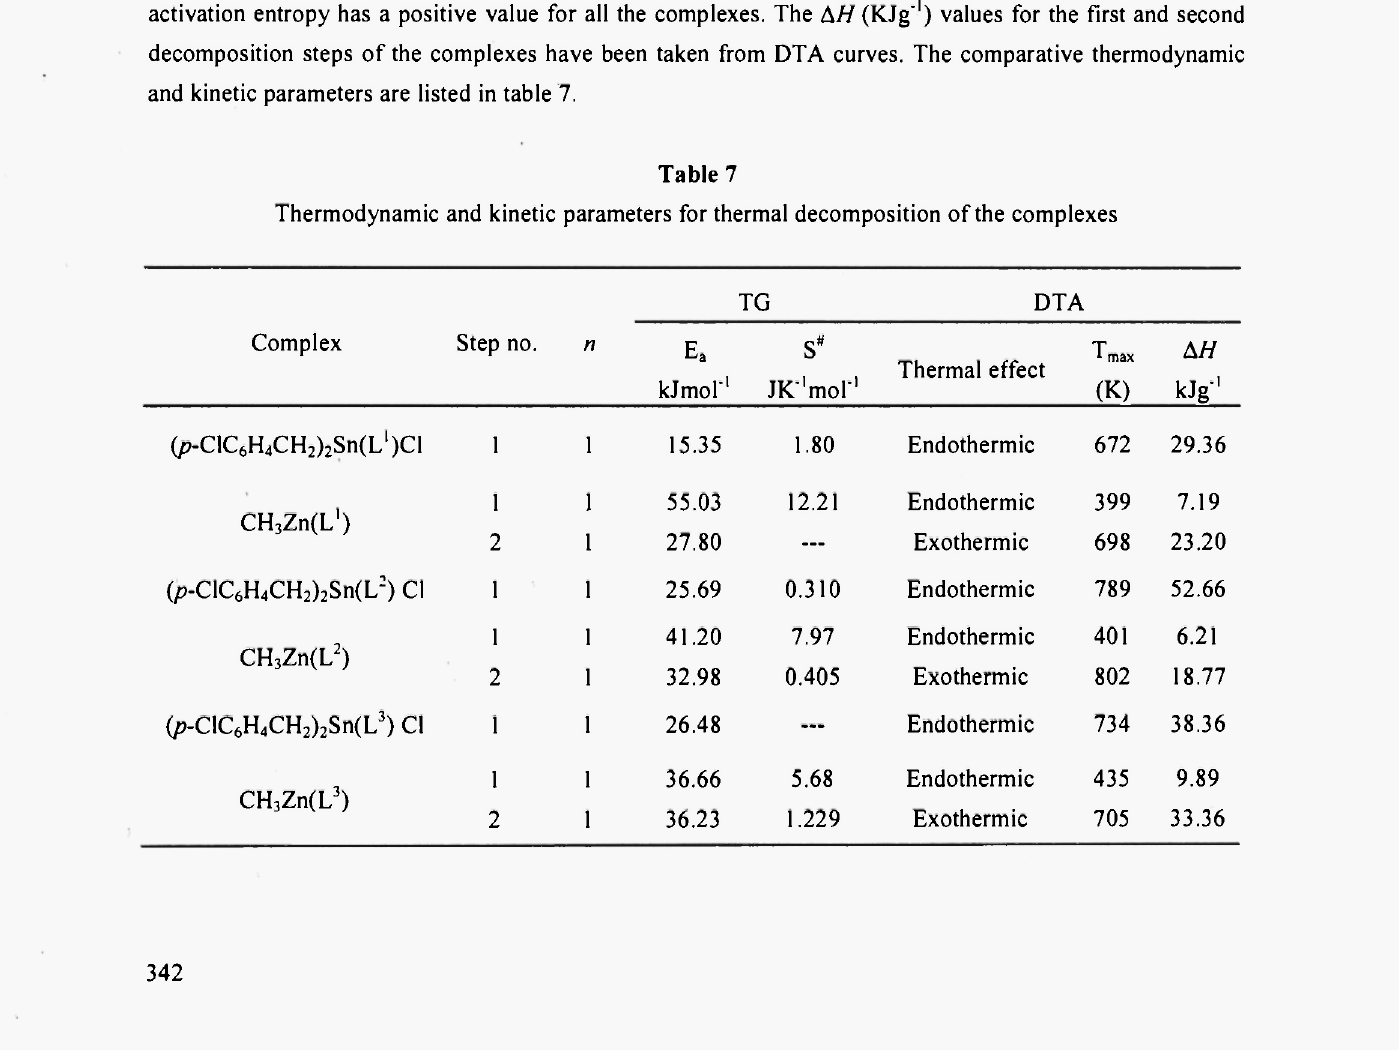
Fig. 4: Linearisation curve for step II of D - CH 3 Zn(L'), Ε - CH 3 Zn(L 2 ), F - CH 3 Zn(L 3 )